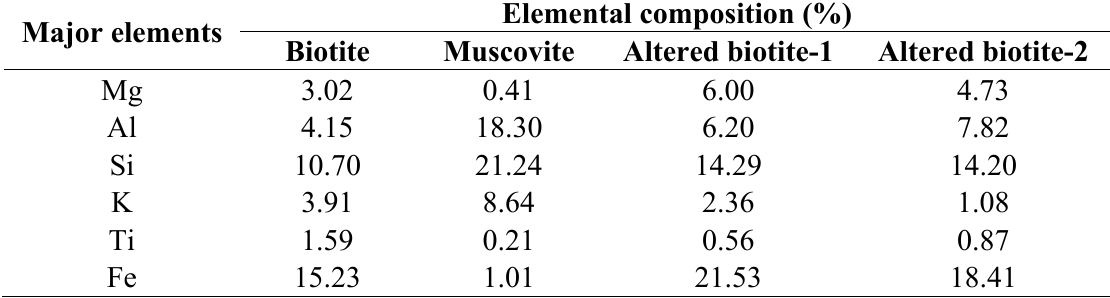
Table 3. Elemental composition of biotite, muscovite and altered biotite in sediments of